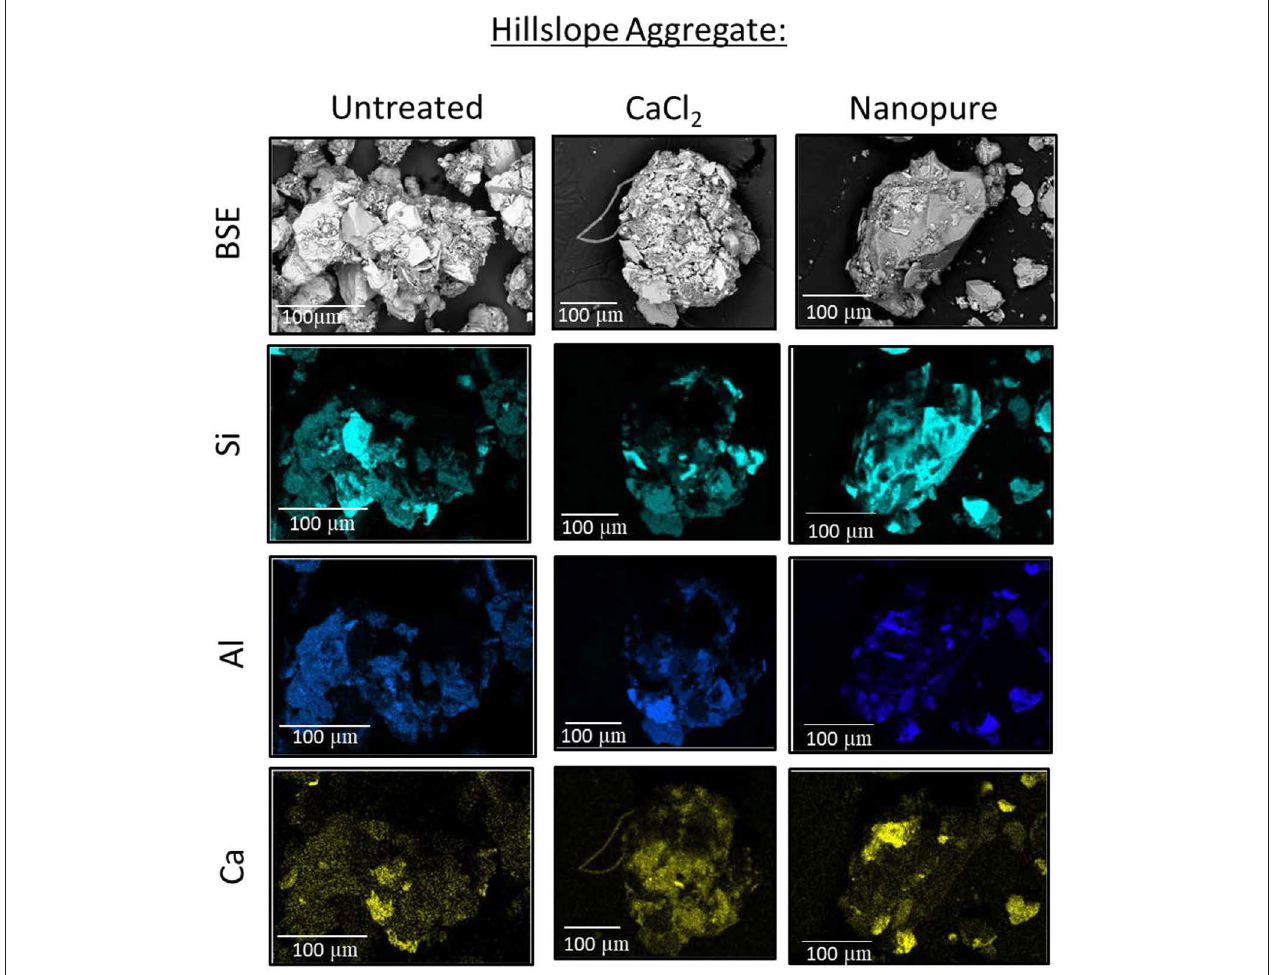
FIGURE 6 | Representative hillslope (HS) aggregate as a backscatter electron (BSE) image. Maps show the distribution of specific elements in untreated air-dried samples ( left ), treated with high ionic strength CaCl 2 solution ( center ), and low ionic strength Nanopure water ( right ).